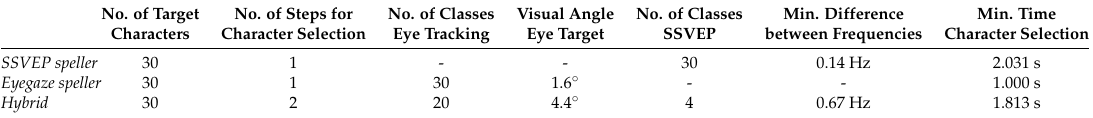
Table 1. Overview of the tested spelling applications: the setaty-state visual evoked potentials (SSVEP) based application ( SSVEP speller ), the eye tracking based application ( Eyegaze speller ), and the here presented hybrid application ( Hybrid ). The main differences between the three systems are provided.